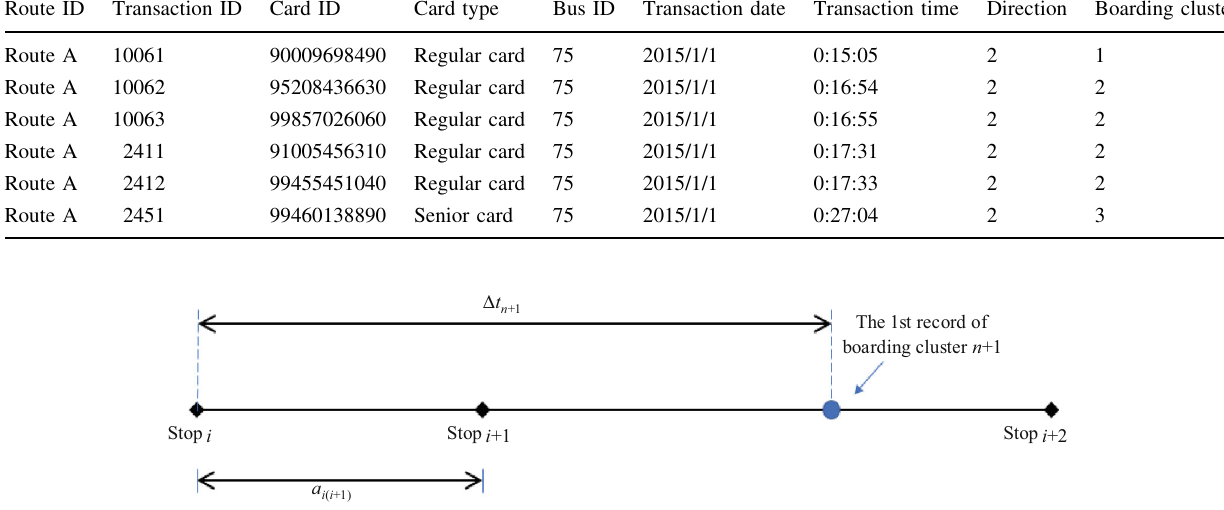
Table 3 An example of the boarding cluster identification results Route ID